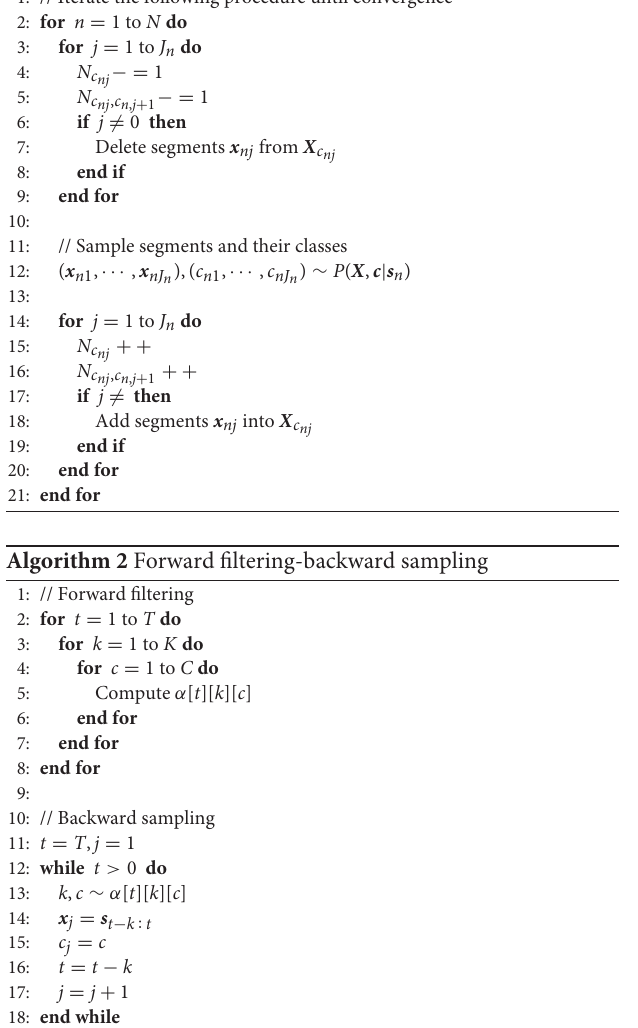
Figure 5 , the probability that k samples s t − k : t prior to time